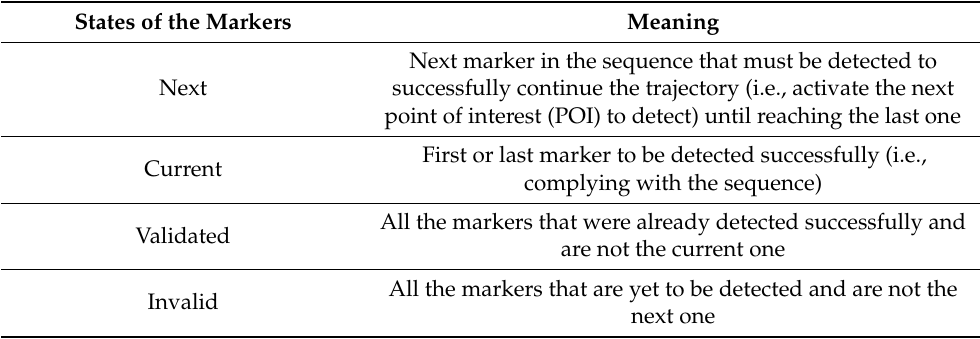
Table 3. Meanings of the four statuses that define the markers during the AR